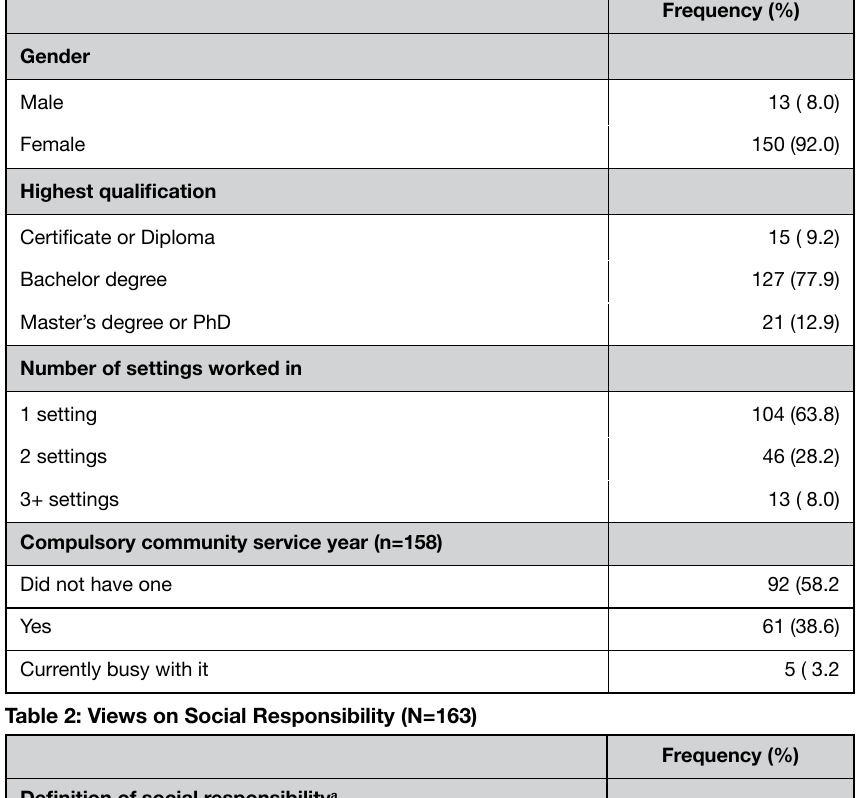
Table 1: characteristics of the sample (N=163)